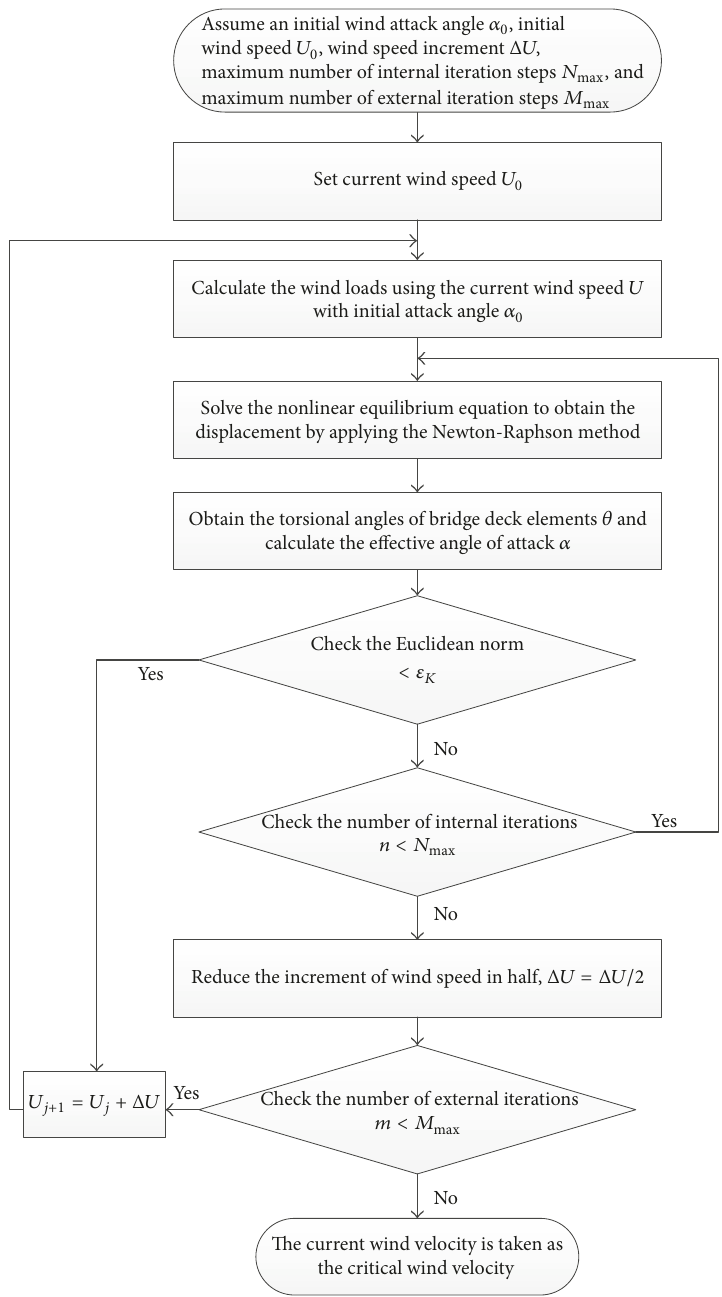
Figure 3: The flow chart of the procedure of aerostatic instability analysis method.